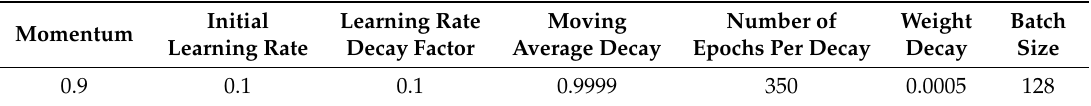
Table 2 . Hyperparameters used in the implemented AlexNet network.